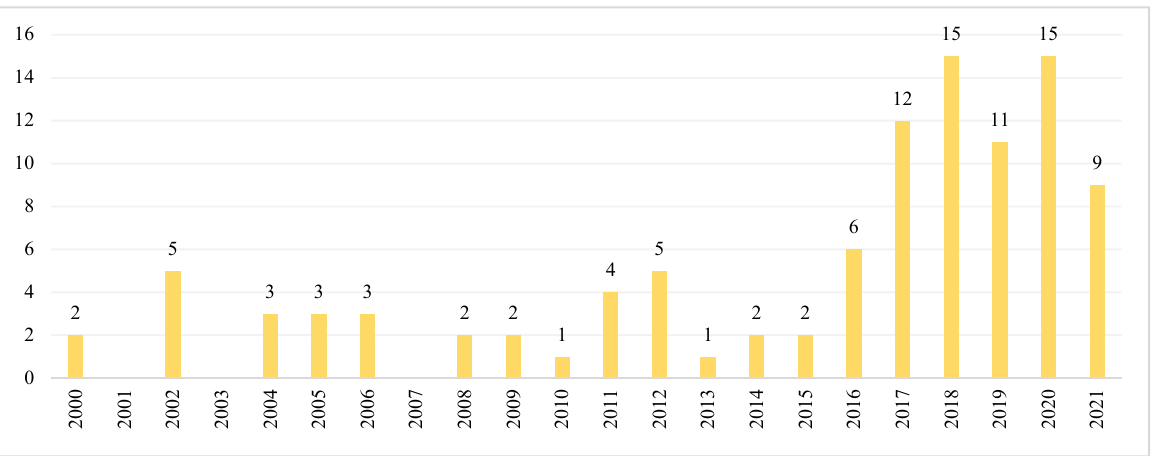
Figure 2. Insurance AI Articles Meeting Relevance Threshold (2000–2021) outlines the number of systematically reviewed articles by year according to the inclusion and exclusion criteria outlined in Section 3.1.